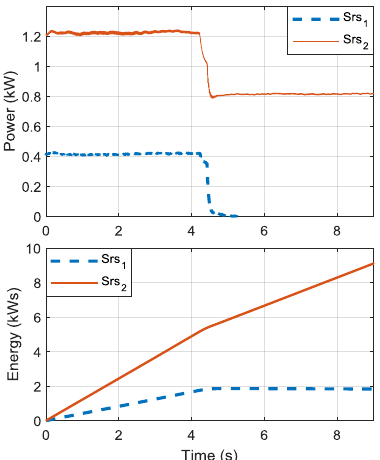
Energies 2019 , 12 , x FOR PEER REVIEW Figure 10. Power and energy supplied by Src1 and Src2 in case study I. Figure 10. Power and energy supplied by Src1 and Src2 in case study I.